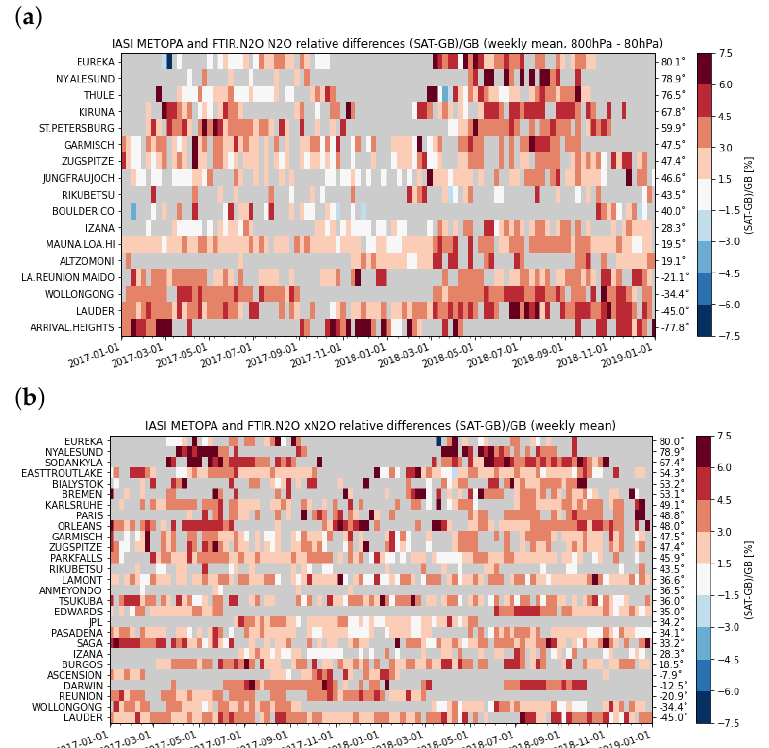
Figure 18. Same as Figure 16 for the TCCON Wollongong station but here in terms of dry-air column-averaged mole fractions, the standard TCCON unit.